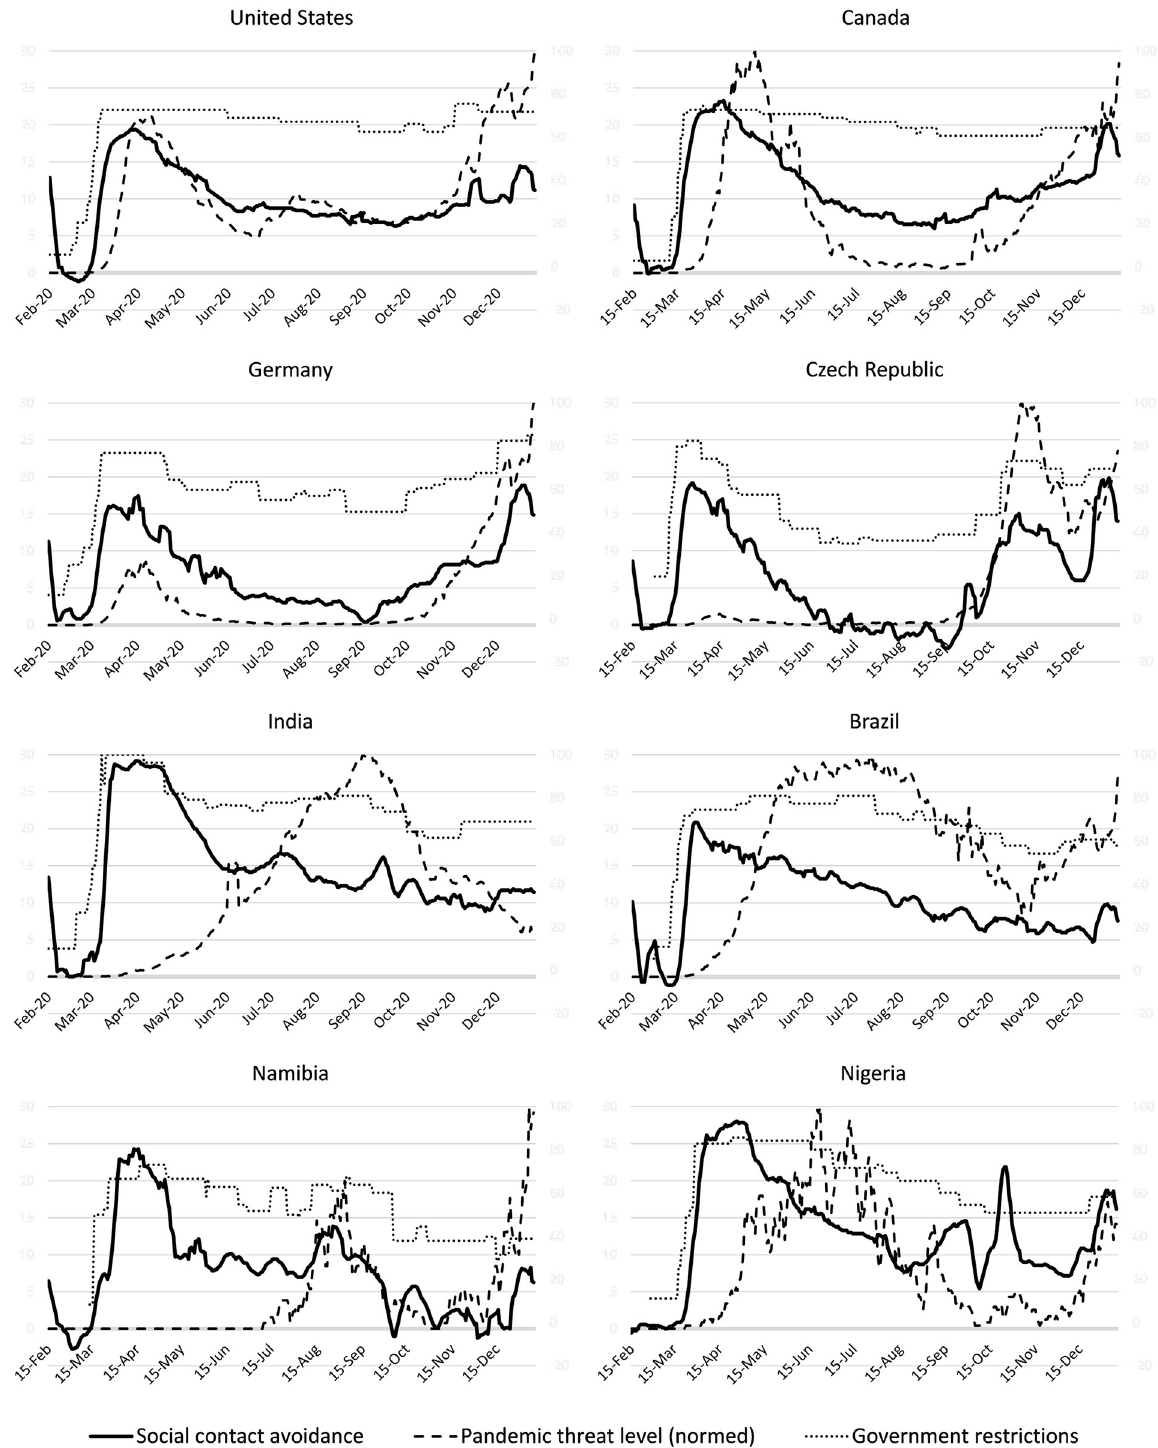
Fig 2. Social contact avoidance, pandemic threat level, and government restrictions. For eight countries from different geographies, this figure shows the extent of social contact avoidance (solid black line) from February 15, 2020 to January 10, 2021, alongside the pandemic threat level (dashed grey line), and government restrictions (dotted grey line). All three lines are on a separate scale; the line for the pandemic threat level is normed between zero and the country’s maximum threat level during the time period.